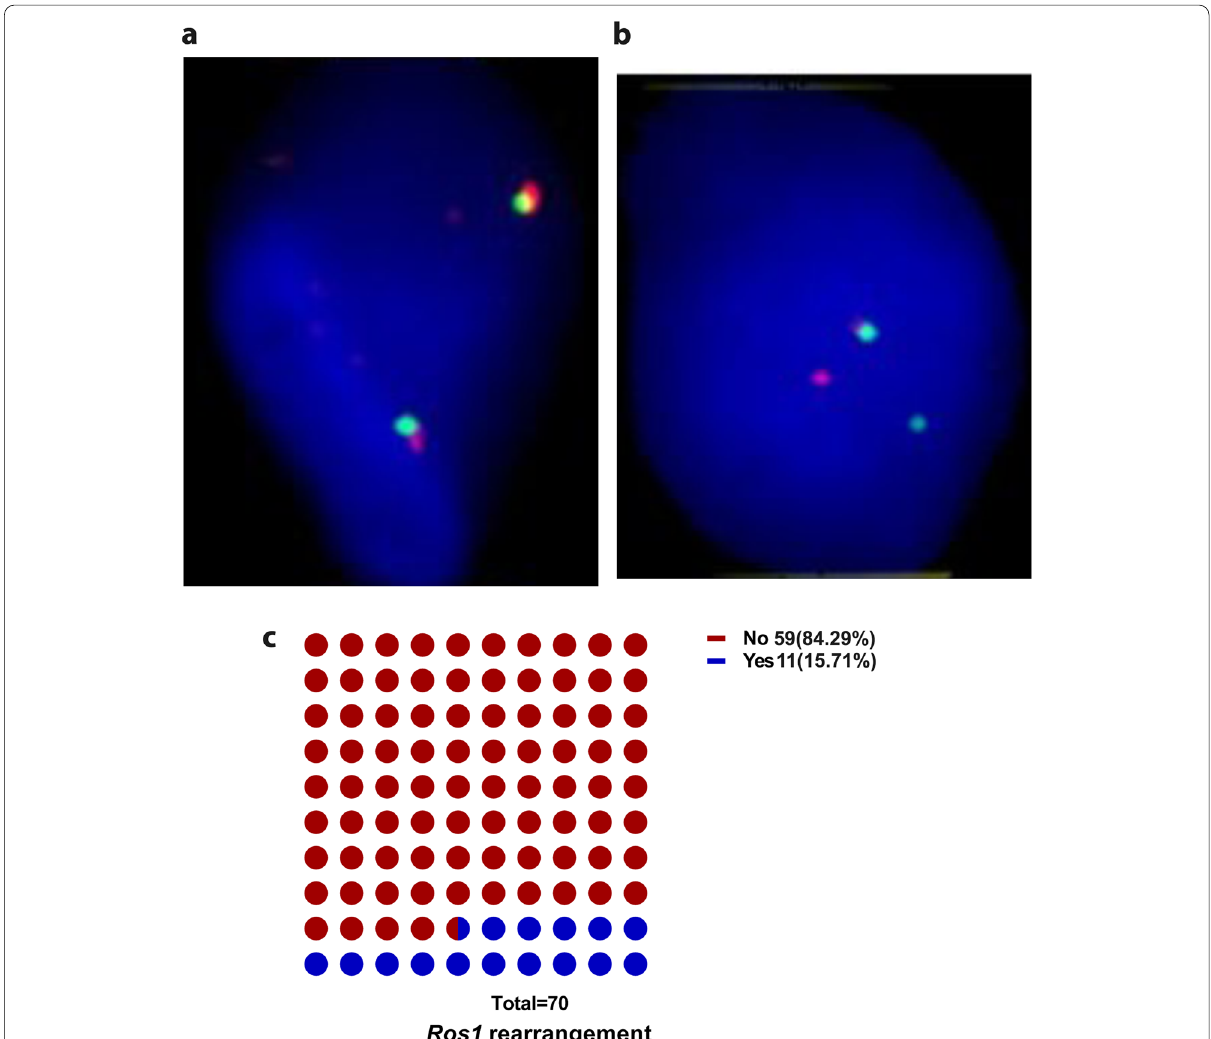
Fig. 2 Detection of ROS1 gene rearrangement using FISH. a FISH‑negative case showing intact two fused signals per nucleus. b FISH‑positive cases representing split (red and green) signals. Original magnification 1000. c Bar plot showing the frequency of the ROS1 gene ×